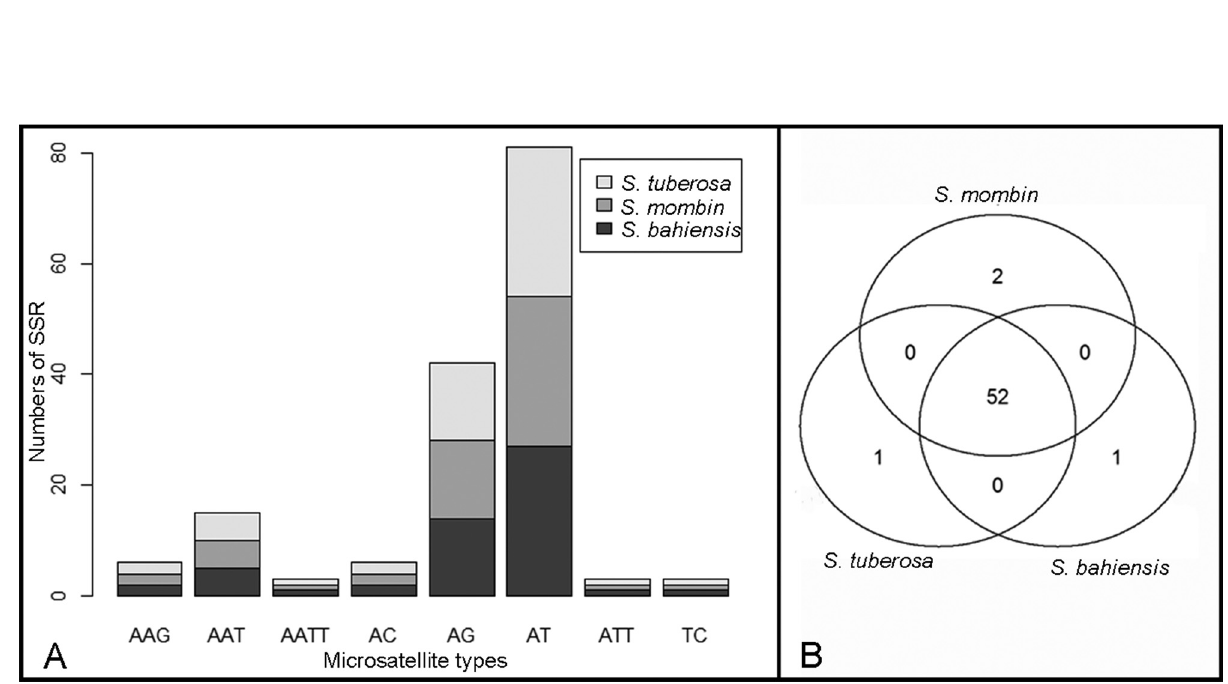
Figure 2 - Comparative analysis of microsatellites in the chloroplast genomes of Spondias . (A) Microsatellite type distribution in three Spondias species. (B) Venn diagram showing the number of SSR that are shared among S. bahiensis , S. tuberosa , and S. mombin